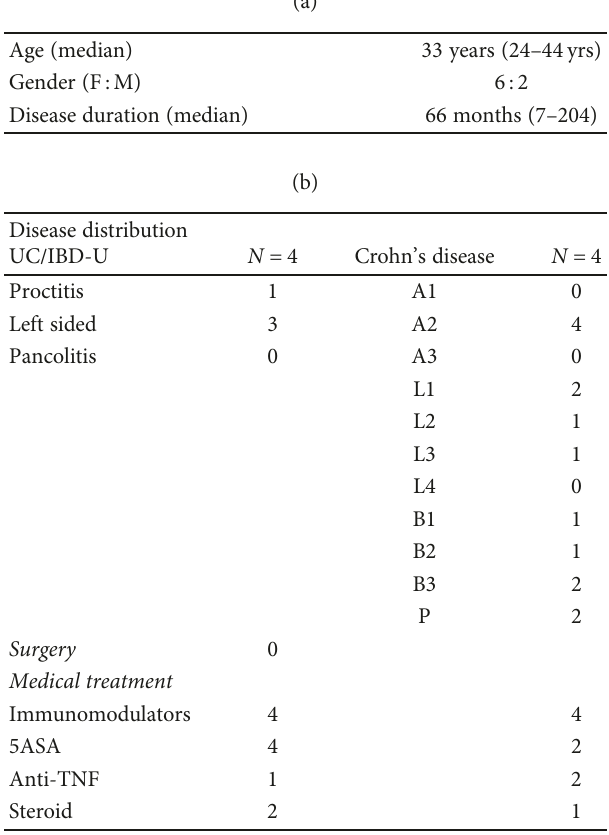
Table 1: Patient characteristics, demographics, and disease distribution.